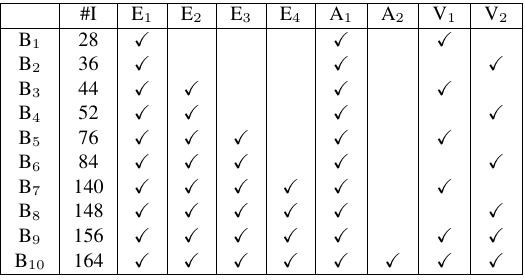
Table 2: Number of images and fundamental sets of cameras composing the subsets of Scenario B.